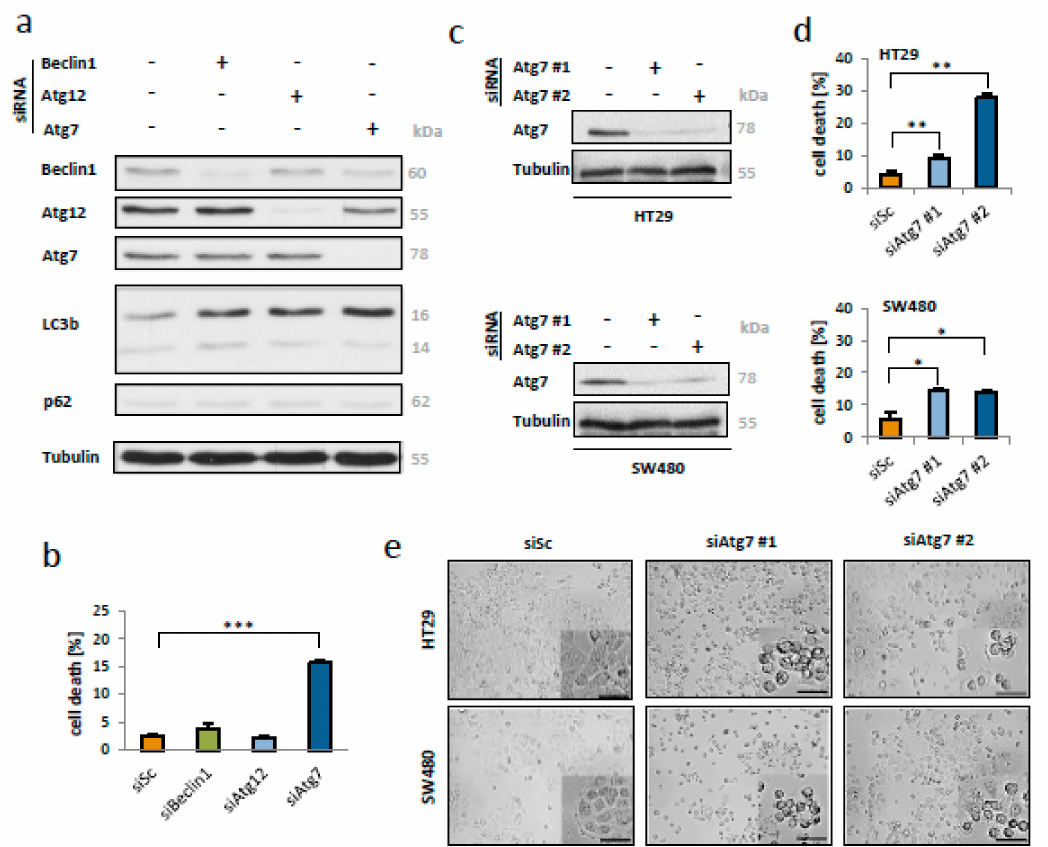
Figure 2. Knockdown of Atg7 but not Beclin-1 or Atg12 induced death of colorectal cancer cells. ( a ) Western blotting for key autophagy proteins after siRNA-mediated knockdown (80 nM) of Beclin-1, Atg12 and Atg7 in HT29 cells. ( b ) Flow cytometry for DNA fragmentation indicating apoptosis after silencing of Beclin-1, Atg12 and Atg7. *** = p < 0.001. Data represent mean + SD of independent biological triplicates. ( c ) Western blot analysis for Atg7 after knockdown of Atg7 with two di ff erent siRNAs (#1 and #2; 80 nM each) in HT29 and SW480 cells for 48 h. ( d ) Flow cytometry indicating apoptosis induction after transfection with two di ff erent siRNAs targeting Atg7 (#1 and #2; 80 nM each) in HT29 and SW480 cells for 48 h. * = p < 0.05, ** = p < 0.01. ( e ) Bright field microscopy of HT29 and SW480 cells after silencing with two di ff erent siRNAs targeting Atg7 (#1 and #2; 80 nM each; scale bar indicates 100 µ